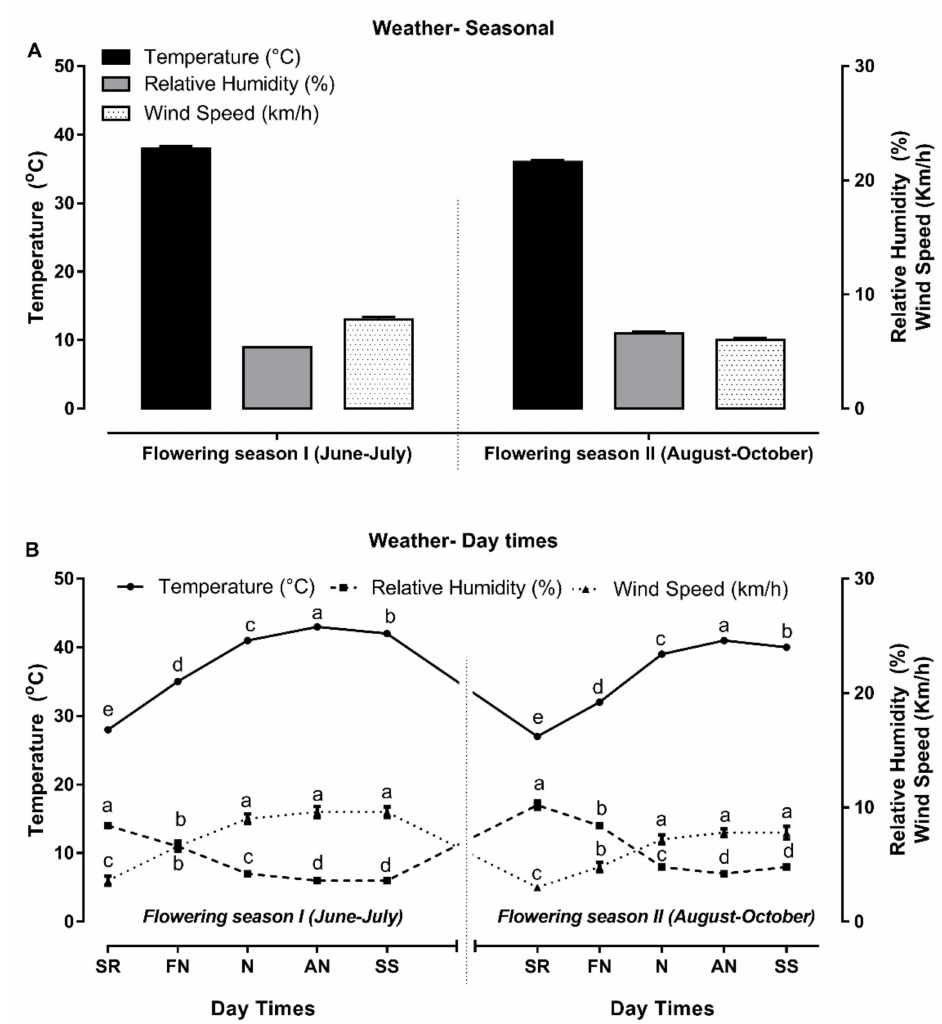
Figure 1. Meteorological temperature ( ◦ C), relative humidity (%) and wind speed (km/h) data recorded during the flowering seasons of Z. nummularia in central Arabia. ( A ) Seasonal patterns of weather factors (mean ± SEM) in each flowering season (season I and season II). ( B ) Daily patterns of weather factors (mean ± SEM) registered at different times of day (SR: sunrise, FN: forenoon, N: noon, AN: afternoon, and SS: sunset). Different letters indicate significant differences among the mean values of a single weather factor at different times of day at p < 0.05. SEM: standard error of the mean. Flowering season I was from June–July, and flowing season II was from